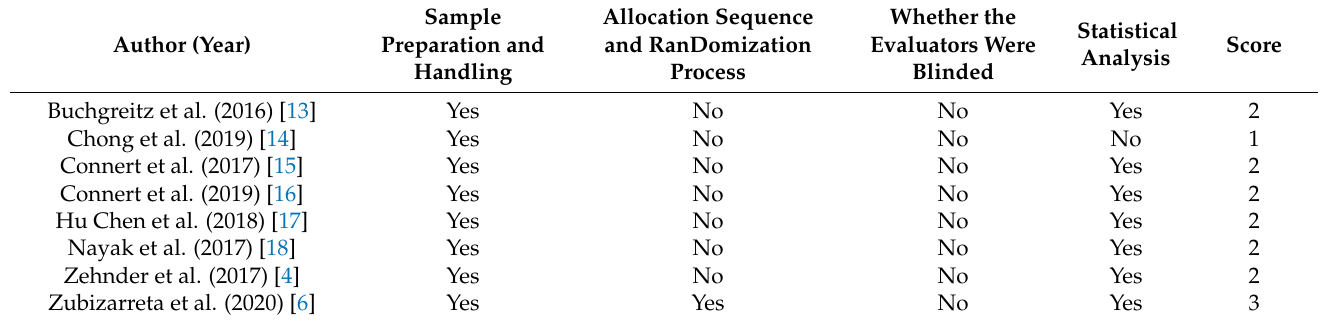
Table 2. Methodological quality assessment as per the Current Research Information System (CRIS) scale.